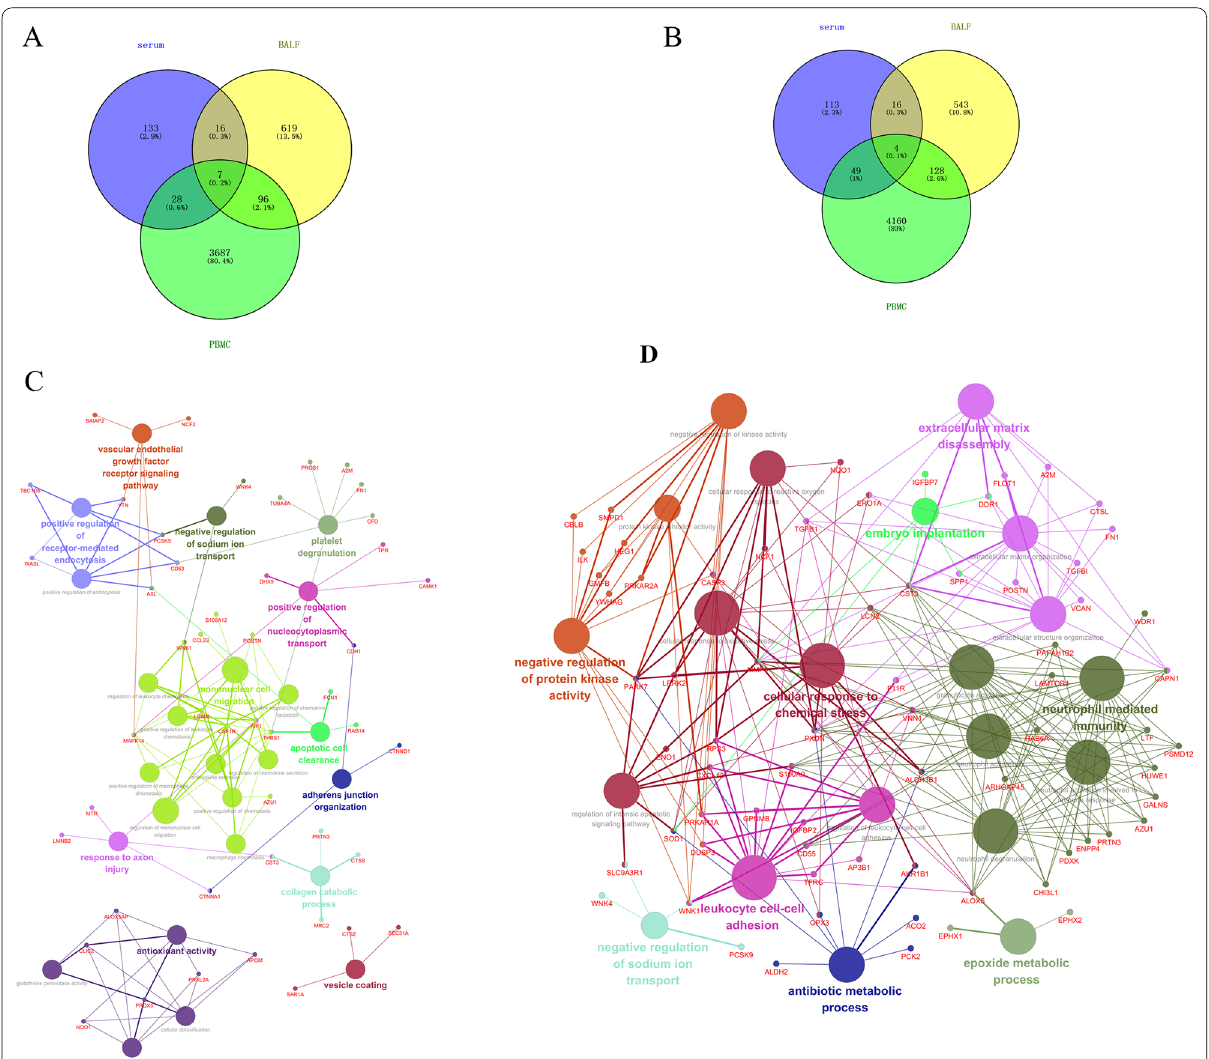
Fig. 4 Visualization of common DEMs in serum, BALF and PBMCs during APP infection. Venn diagram shows DEMs at 0–24 h ( A ) and at 24–120 h ( B ). Cytoscape ClueGO analysis identified the link between the common DEMs and its related KEGGs at 0–24 h and at 24–120 h ( D ). Each cross-node represents a cross-talk gene (different circles indicate signal pathways where DEGs are enriched and genes on branches indicate DEMs involved in the signaling